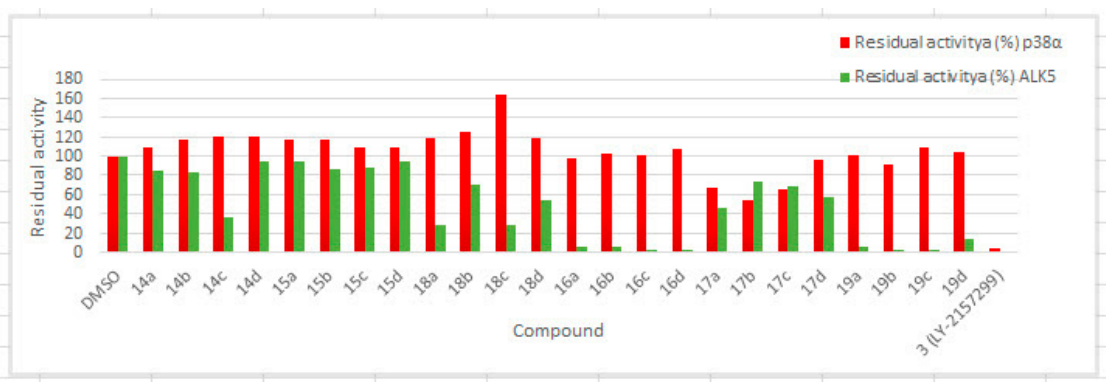
Figure 3. Residual activities of ALK5 and p38 α MAP kinase in the presence of 3-substituted-4- (quinoxalin-6-yl)pyrazoles 14a – d , 15a – d , 16a – d , 17a – d , 18a – d , and 19a –